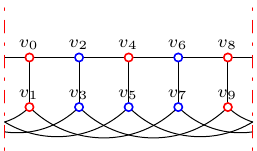
Figure 14. Segment of f in Case 2.2 in Lemma 8.